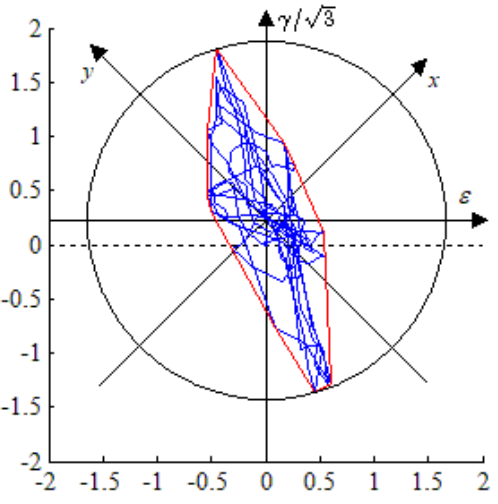
Figure 16. Strain path and equivalent convex path on the critical plane of NWB_2.